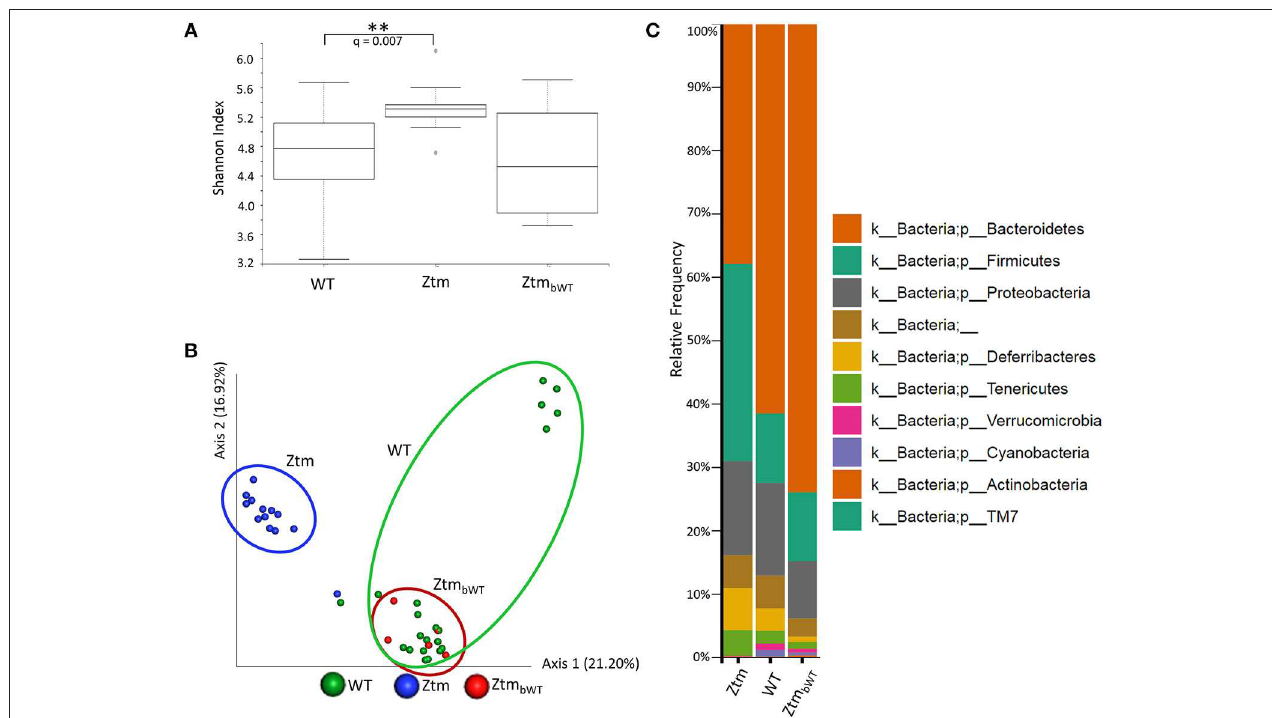
FIGURE 4 | Microbiota analysis of Ztm mice with and without bedding transfer. Stools recovered from the colon of both male and female pups were analyzed as described in the material and methods. Stools were collected at weaning. Ztm bWT represent pups that were subjected to bedding transfer from WT. Bedding transfer was carried out twice a week since birth. (A) Shannon Index, expression of alpha diversity (variation/complexity of the microbiome within the group). WT n = 21, Ztm n = 13, Ztm bWT n = 5. WT and Ztm have a significantly different ( q = 0.007) microbiota diversity, whereas no statistical difference is observed between WT and Ztm bWT. (B) Microbiota composition at phylum level. Successful engraftment of Verrucomicrobia and Cyanobacteria from WT to Ztm bWT following bedding transfer. (C) Principal component Analysis (PCA) of Jaccard distances. Ztm bWT (red) cluster with WT (green) and separately from Ztm (in blue). Differential abundance